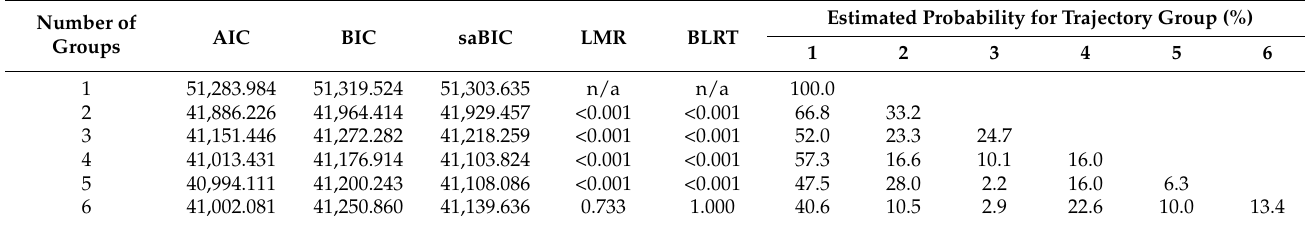
Table 2. Fit indices of latent class analysis and distribution rate of HRQOLs (EQ-5D). Number of